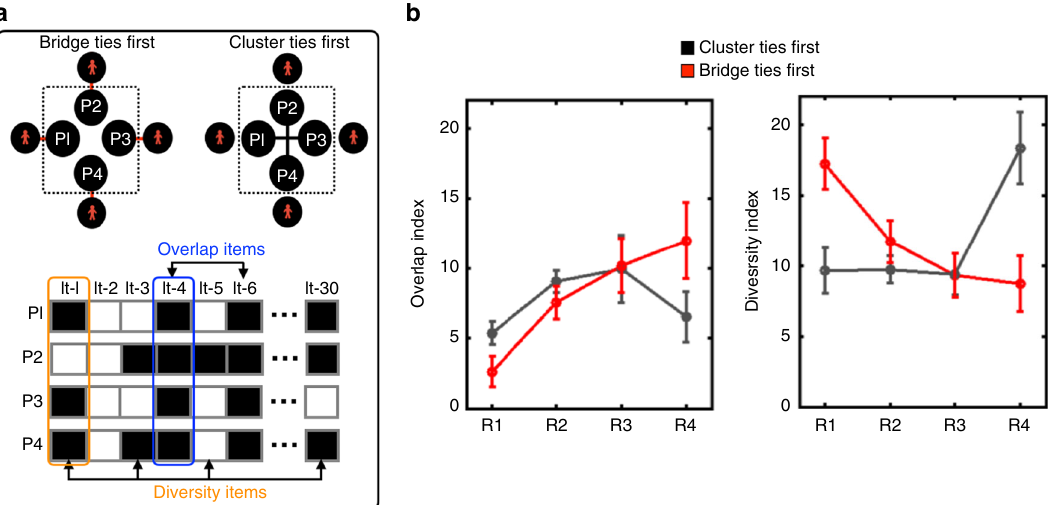
Fig. 4 Memory overlap and memory diversity indices. a For each cluster (designated with the dotted line), we compared vectors corresponding to information that came up in conversations of each of its four members (participants P1 through P4). Some of these conversations were within cluster, and some were between a cluster member and an “ outsider ” (red fi gures). For each round, a cluster ’ s overlap index indicated the number of items (out of the 30 studied items) that came up in conversations of all members (highlighted with the blue box), while the diversity index indicated the number of items that were mentioned in at least one but no more than three conversations (highlighted with the orange box). b The dynamics of the overlap and diversity indices, by round, separate for the Bridge Ties First (red) and Cluster Ties First (black) conditions. A repeated-measures analysis of variance (ANOVA) revealed that the interaction between Time and Condition is signi fi cant for both the overlap [ F (3, 8) = 11.76, η 2 = 0.81, p = 0.003] and the diversity [ F (3, 8) = 31.53, η 2 = 0.92, p = 0.001] indices, with post-hoc independent-sample t -tests indicating signi fi cant differences between the Bridge and Cluster Ties First conditions in both Round 1 (Overlap: t (10) = 4.97, d = 2.89, con fi dence interval (CI) [1.52, 3.98], p < 0.001; Diversity: t (10) = 7.69, d = 4.46,